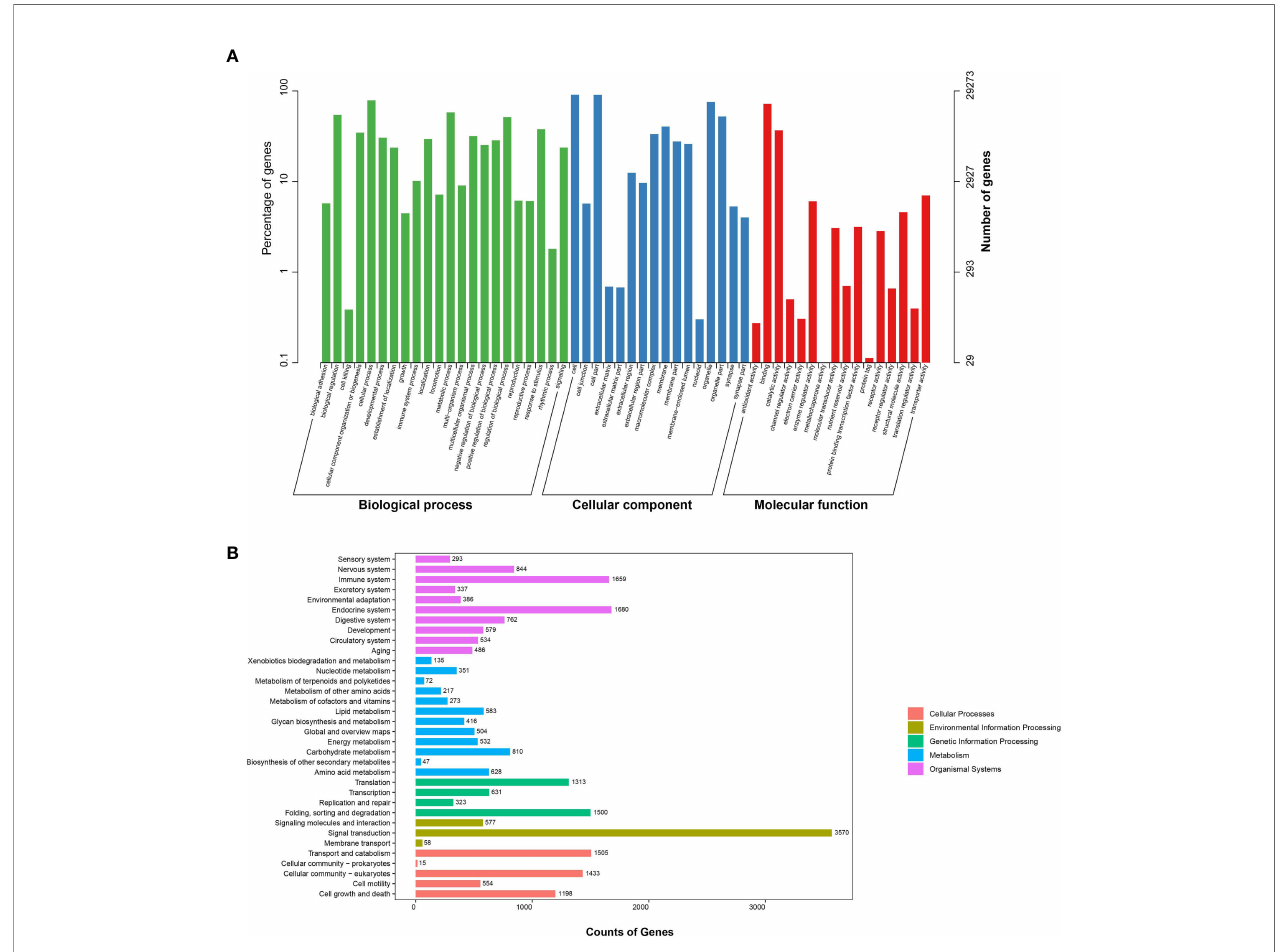
FIGURE 1 | Functional classi fi cation of Tanichthys albonubes transcriptome. (A) Two level of GO functional annotations of full-length transcripts. (B) KEGG classi fi cation of full-length